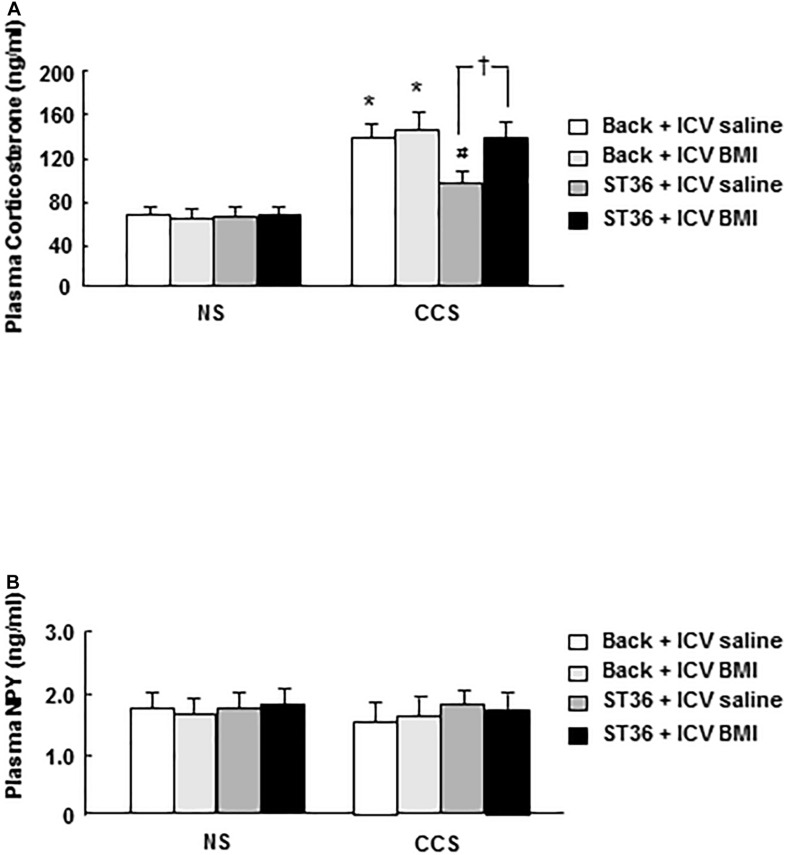
Effects of EA at ST-36 and GABAA receptor antagonist on serum corticosterone (A) and NPY (B) levels in response to CCS. (A) In the NS groups, serum corticosterone concentration showed low level, EA at back (with ICV administered saline or BMI) did not change the corticosterone level significantly. However, EA at ST-36 (with ICV administered saline or BMI) also did not change the corticosterone level significantly. In the CCS conditions, CCS highly elevated the serum corticosterone level in the sham group (EA at back, and saline ICV administered). In the EA at back groups, ICV administered BMI did not change the corticosterone level significantly. However, in the EA at ST-36 groups, the significantly decreased corticosterone level was completely antagonized by ICV administered BMI. (B) In the NS groups, serum NPY concentration showed low level, EA at back (with ICV administered saline or BMI) did not change the NPY level significantly. However, EA at ST-36 (with ICV administered saline or BMI) also did not change the NPY level significantly. In the CCS conditions, the serum NPY level in the sham group did not show significant change. In the EA at back groups, ICV administered BMI did not change the NPY level significantly. However, EA at ST-36 (with ICV administered saline or BMI) also did not change the NPY level significantly (n = 6, *P < 0.05 compared with NS non-treated group, #P < 0.05 compared with CCS non-treated group, †P < 0.05 compared with CCS ST36 + ICV saline group).